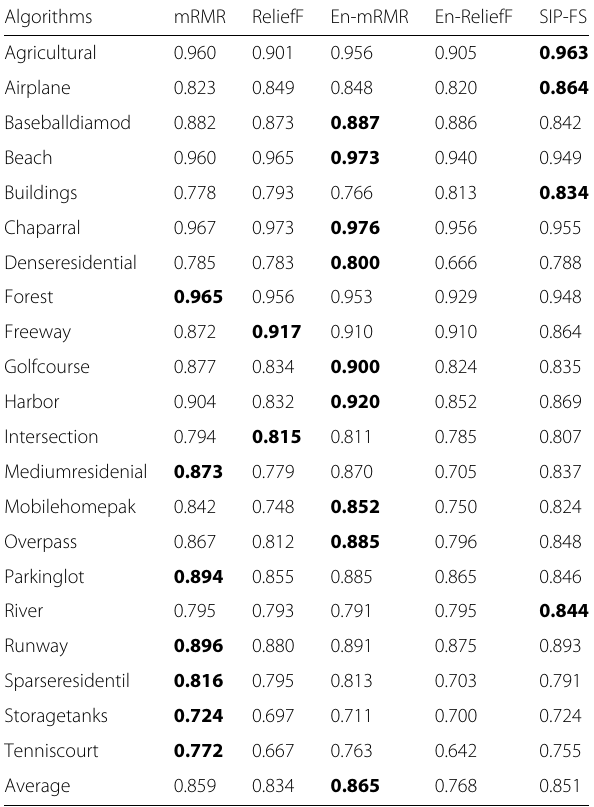
Table 6 Predictability comparisons on USGS21